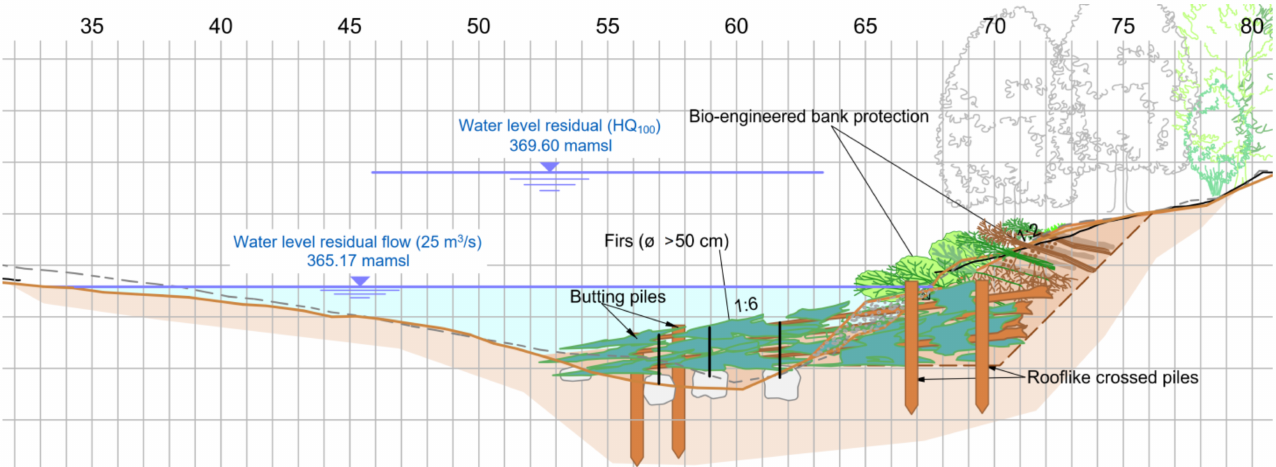
Figure 6. Draft of a submerged tree groin (for a better illustration of rooflike crossed piles see Figure 9b); Aare River; IUB Engineering AG.